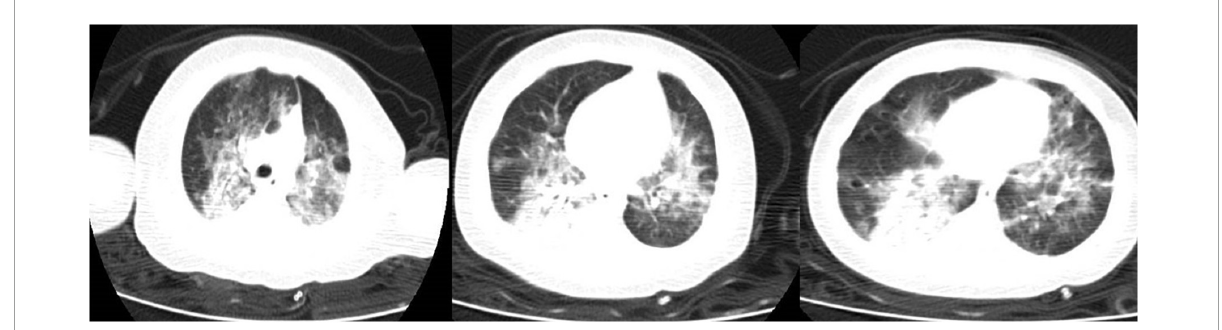
FIGURE1 Chest Computed tomography (CT) scan of the patient showing an interstitial pneumonia.